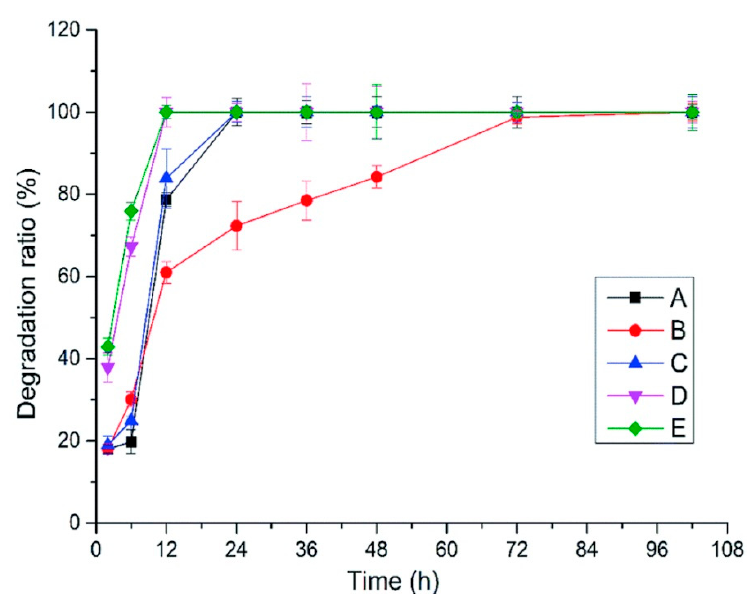
Figure 23. Degradation of crosslinked hydrogels A–E prepared at different mixing ratio in vitro. Reproduced from [133], with permission from The Royal Society of Chemistry (RSC), 2020 Hydrogels D and E were completely degraded after 12 h, C and A were degraded after 24 h, and hydrogel B was degraded after 72 h. It is clear that increase in LMW HA increases degradation rate, and degradation of hydrogel containing LMW HA alone was the fastest. Interestingly, degradation of hydrogel composed of HMW HA alone was not the slowest. System B, with a mass ratio of HMW HA to LMW HA of 4:1, had the best anti-enzymatic hydrolysis performance. The authors suggest that during the preparation of the hydrogels, the intramolecular hydrogen bonds of both samples of HA were disturbed, thus leading to entanglement of chains and the creation of cooperative complexes. This phenomenon was previously explained by A. Stellavato et al. [134].